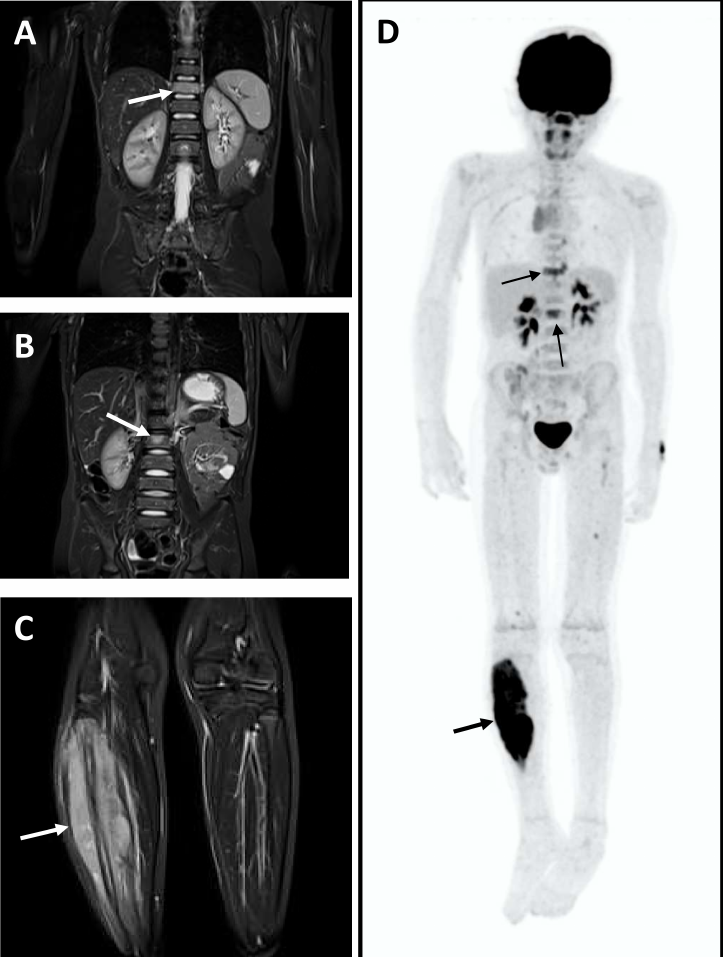
Figure 1. Nine-year-old boy with primary Ewing sarcoma of the right fibula and spinal bone metastases ( A – C ). Coronal STIR MR images from a whole-body MRI study show the primary tumour (arrow— C ) and metastases in the spine (arrows— A , B ). Coronal PET study demonstrates intense FDG uptake in the right fibula ( D ) (thick arrow) and also in the spinal metastases (thin